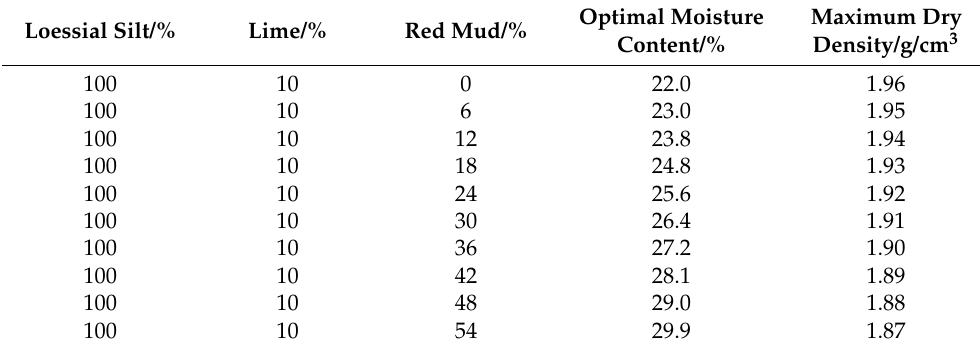
Table 5. Test plans and the compaction test